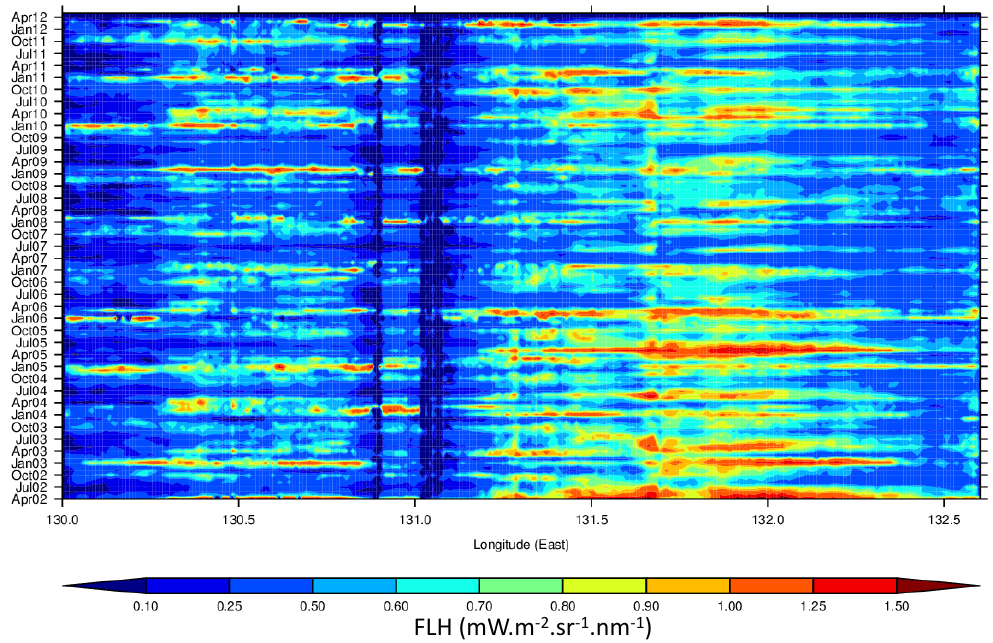
Figure 20. Longitude-time plot of FLH for the VDG cluster.